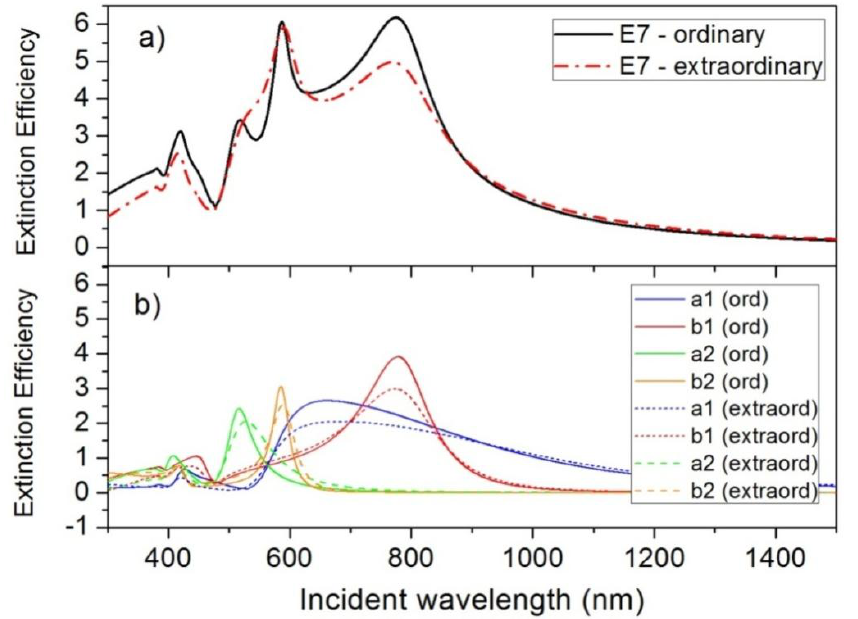
Figure 1. ( a ) Extinction efficiency of a silicon nanoparticle ( R = 100 nm) embedded in an E7 LC when either n or n is considered; ( b ) four first multipolar contributions of the e o extinction efficiency when either the ordinary or extraordinary state of E7 LC is